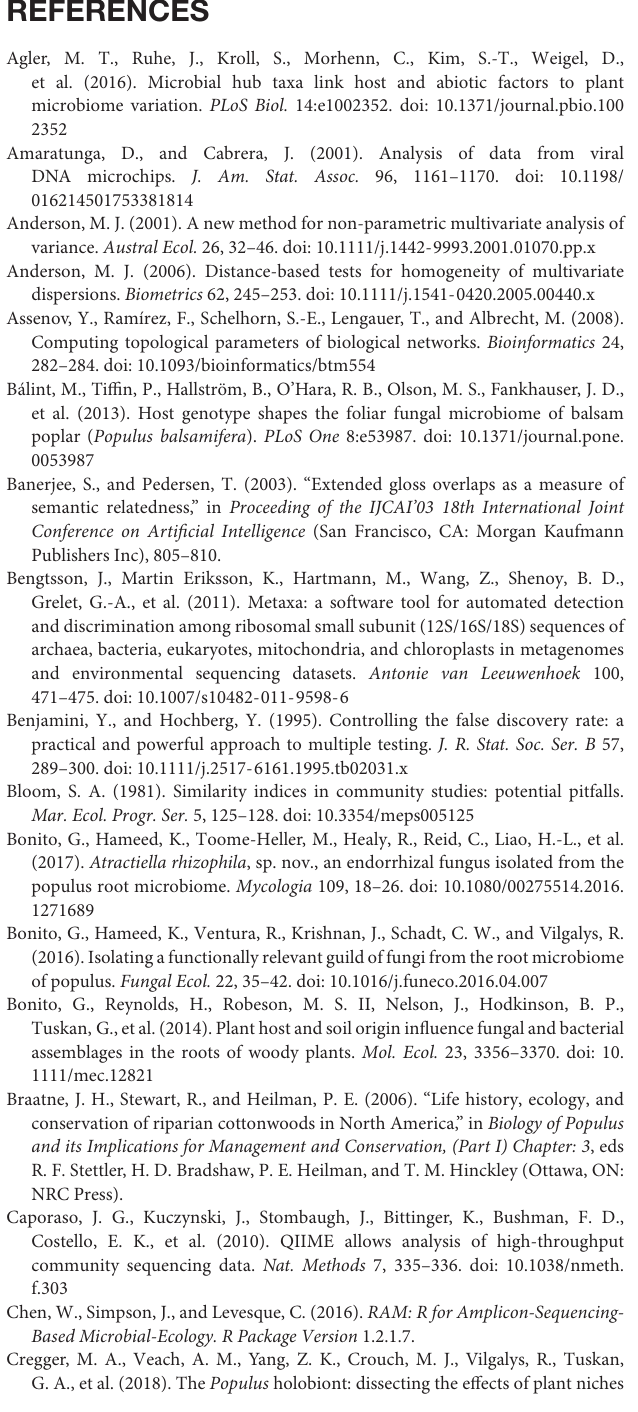
TABLE S9 | Summary of the sizes of Markov Cluster (MCL) communities for Experiment 2, as we as the number of fungi vs bacterial members. FILE S1 | Assessments of arbuscular mycorrhizal fungal